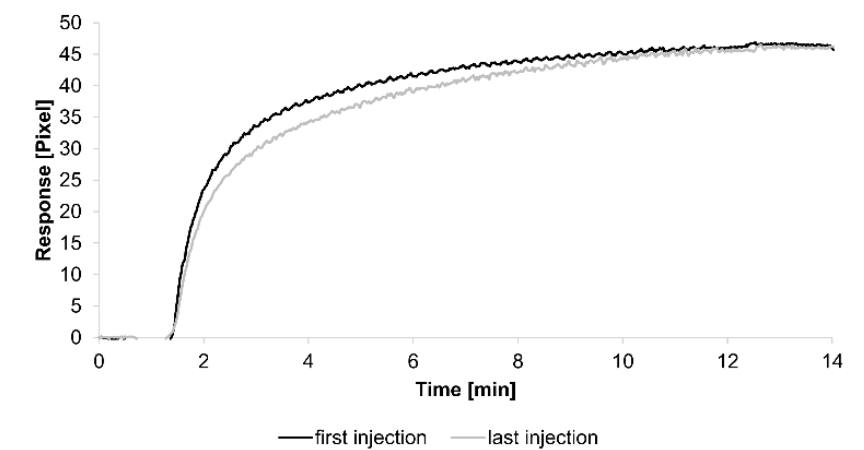
Figure 1. Sensorgrams showing the binding response of injections of 0.7 µM human serum albumin (HSA)-specific antibody before and after the kinetic measurements. Values resulting from the average of two sensing spots and the subtraction of reference surface signals from raw signal measurements are presented on the graph.